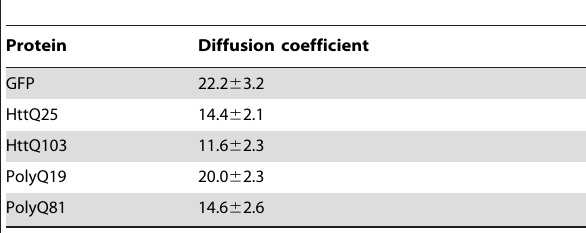
Table 2. Diffusion coefficients of different polyQproteins. a